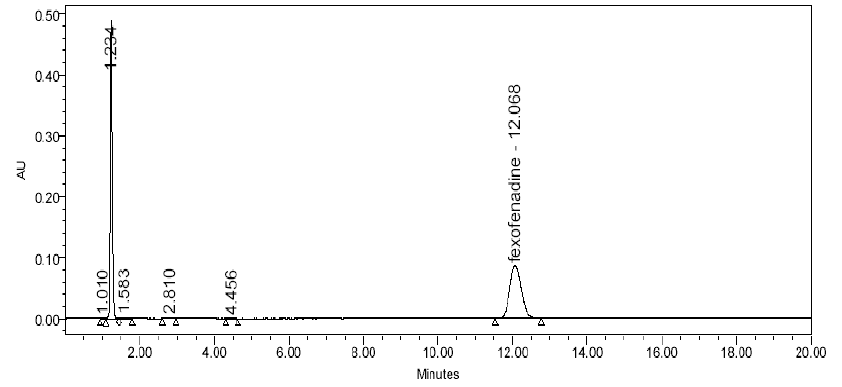
Figure 5. Chromatogram of H chemically oxidized fexofenadine using 3% H 1.234